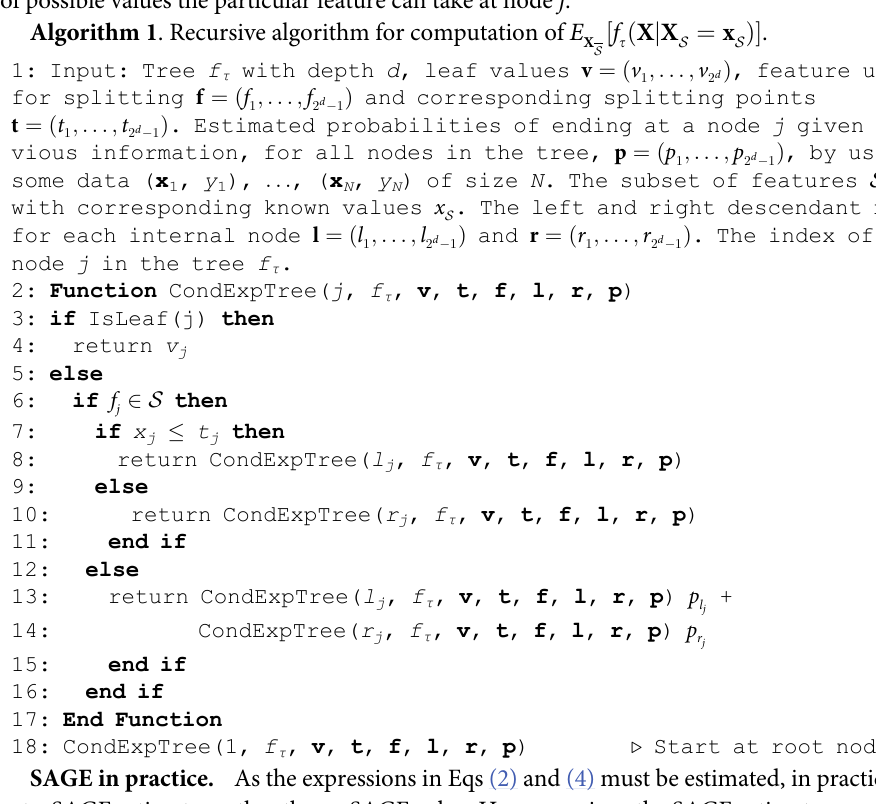
Algorithm 1 . Recursive algorithm for computation of E